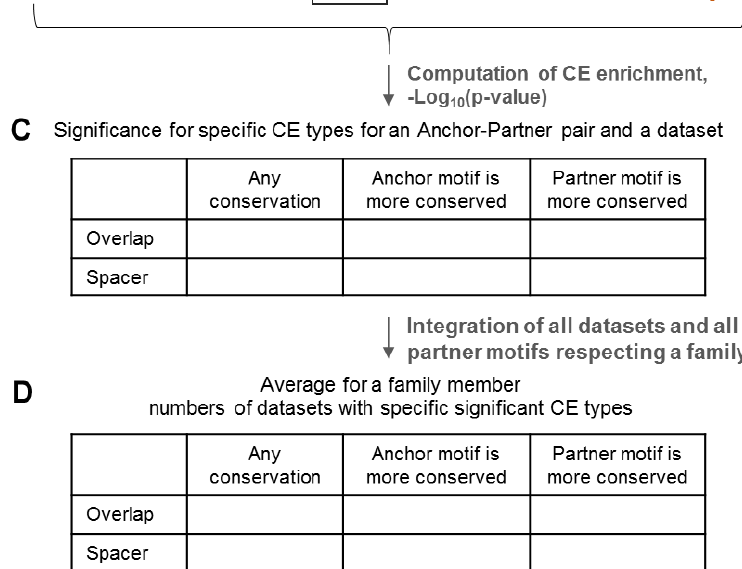
Figure 1. The workflow of the motifs co-occurrence tool (MCOT) application in the current study.